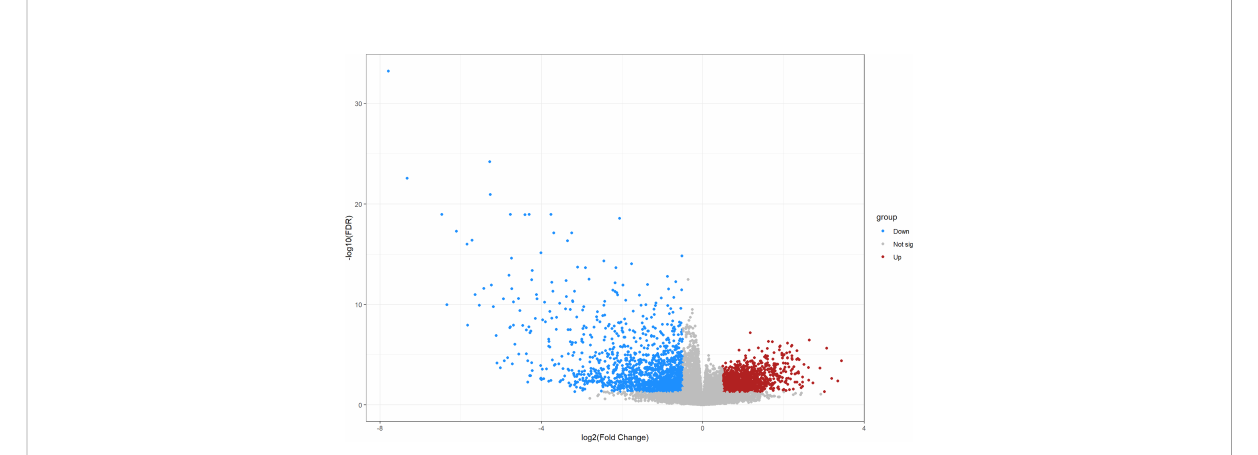
FIGURE 1 Volcano map illustrating all differentially expressed genes between osteosarcoma and non-osteosarcoma